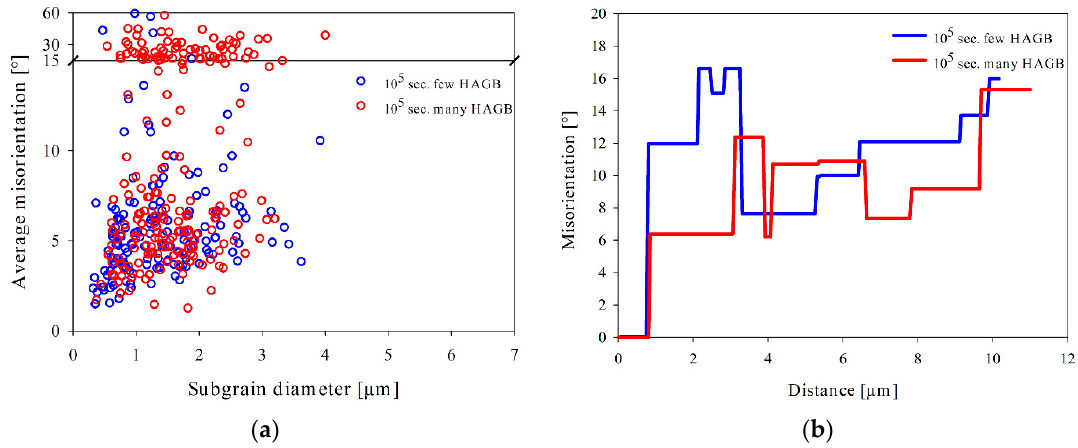
Figure 16. Size versus misorientation plot ( a ) and orientation gradients ( b ) in the ND direction of ND-RD sections from CP Al samples with Cu-oriented subgrains annealed for 10 5 at 250 °C, where the average subgrain size of the HAGB case is only 16% larger but has 5 times as many high-angle grain boundaries.